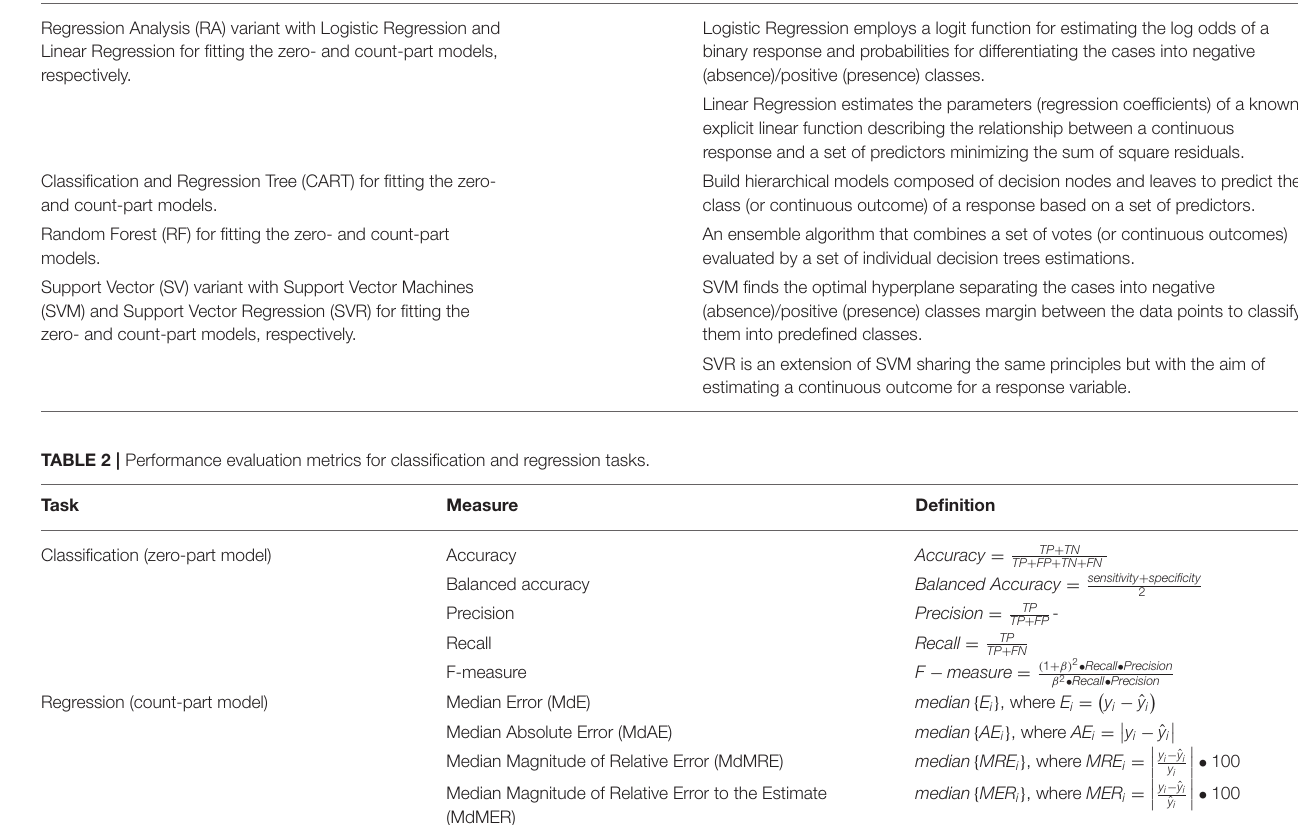
TABLE 1 | Classification and regression methods for building the zero- and count-part models. Method General idea Regression Analysis (RA) variant with Logistic Regression and Linear Regression for fitting the zero- and count-part models, respectively.